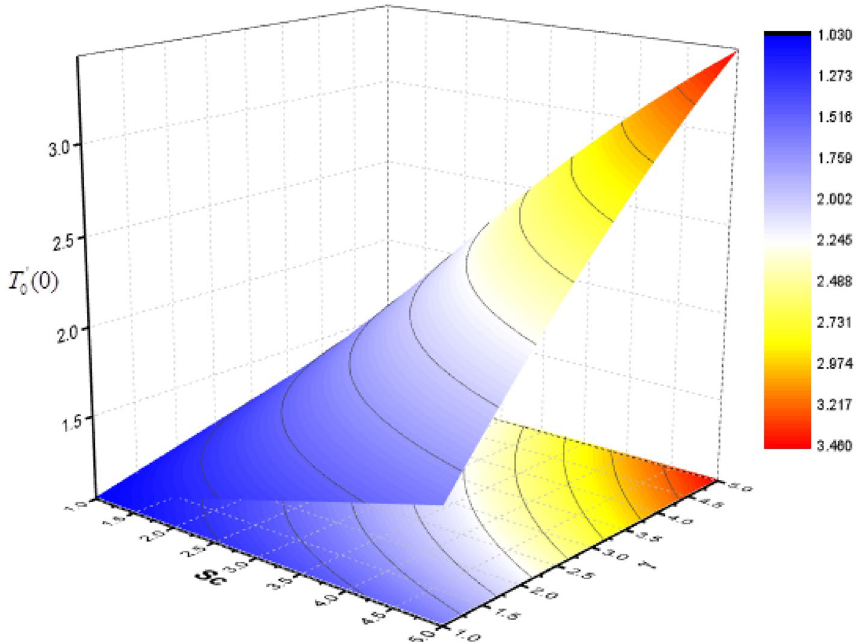
Figure 22. Consequence of Sc and ϒ on T ′ 0 ( 0 )